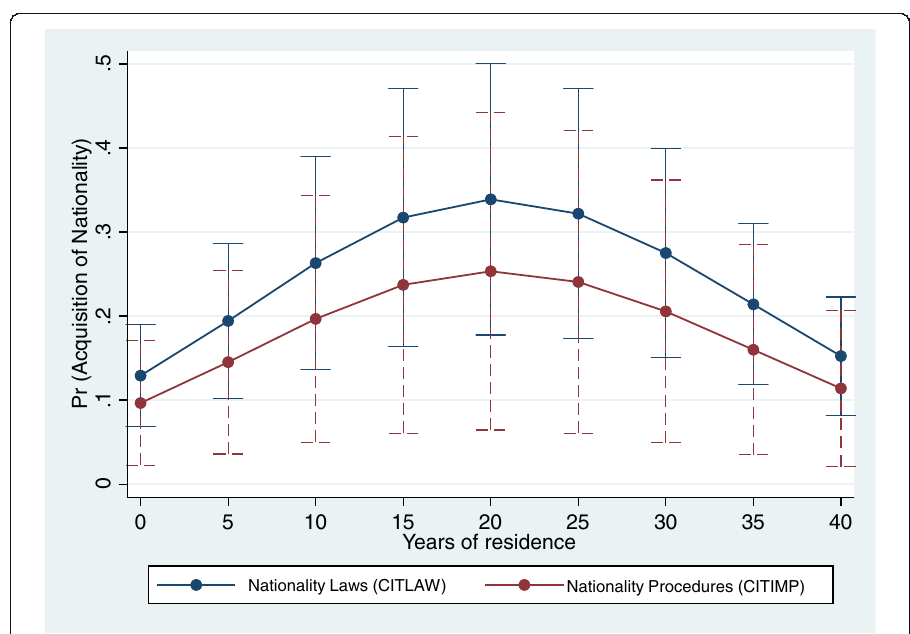
Fig. 1 Average marginal effects of nationality laws on ability to acquire nationality. Calculations are based on Model 2a (Table 4) and include 95% confidence